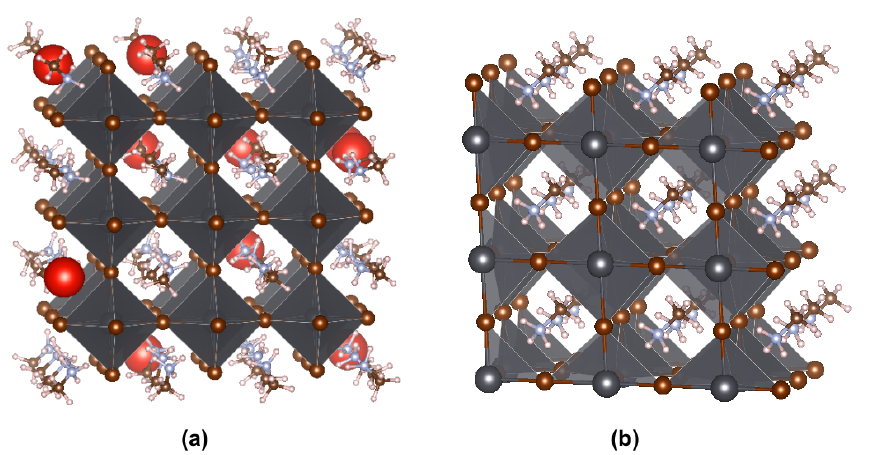
Figure 1. Neutral 3 × 3 × 3 quantum dots. In ( a ), the main building block is the BX 6 octahedron. If all interstitial sites are occupied by A cations, then the resulting structure exhibits an excess of positive charge ( + 10 for the specific dot). Neutrality may be achieved by randomly removing the appropriate number of A cations (for example, random sites are indicated by the large red spheres). In ( b ), the main building block is the ABX 3 unit. As a result, the resulting nanoparticles are always neutral, but three out of six facets are terminated by truncated